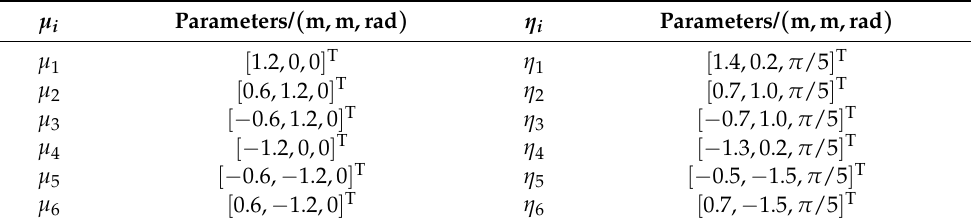
Table 2. The parameters of six